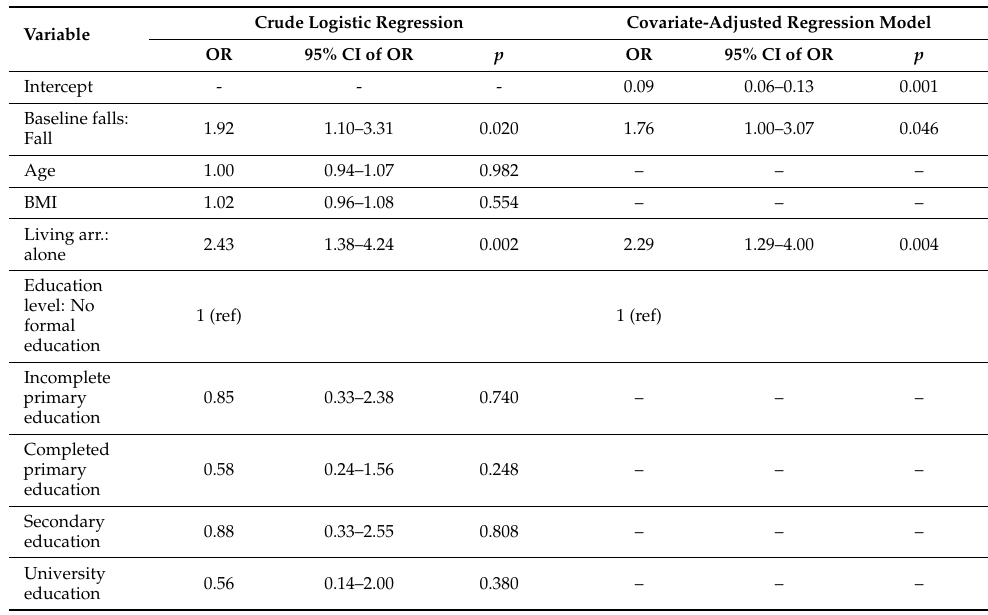
Table 4. Crude and adjusted logistic regression models of falls associated factors at 12 months. Crude Logistic Regression Covariate-Adjusted Regression Model Variable OR 95% CI of OR p OR 95% CI of OR p Intercept - - - Baseline falls: